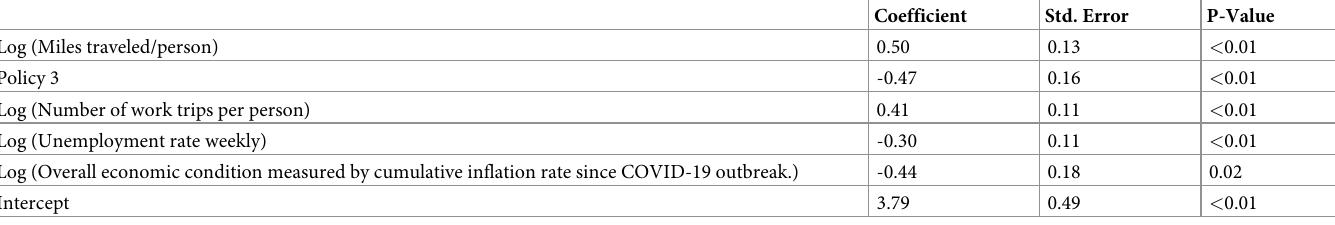
Table 3. Negative binomial model of person involved in crash during COVID-19 pandemic.